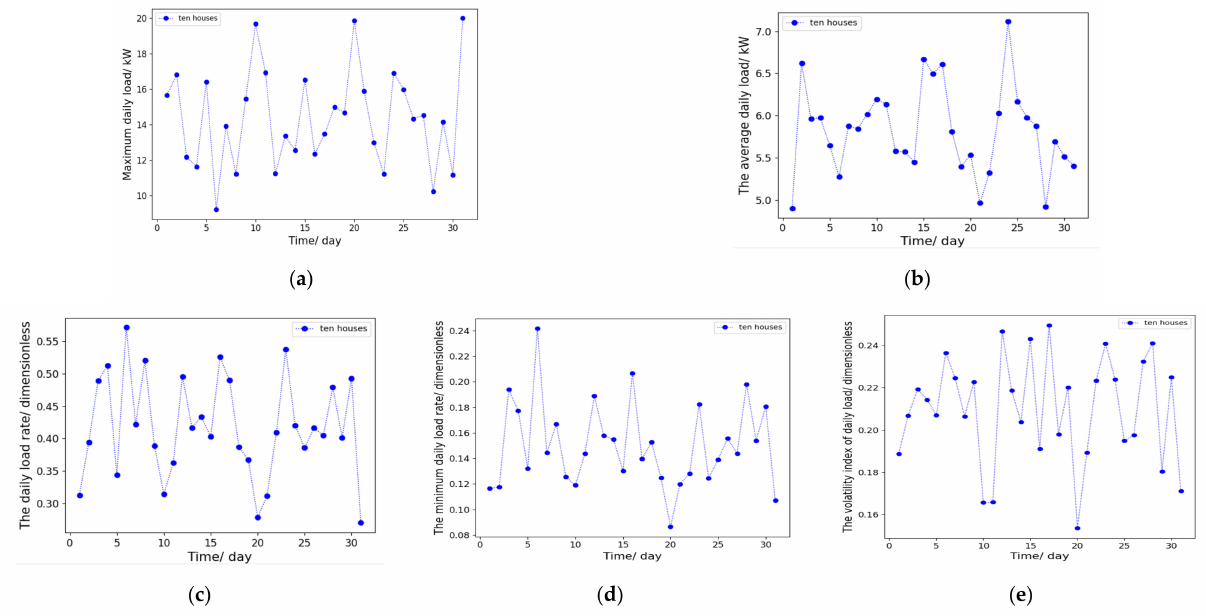
Figure 4. The quantitative indexes of total electric loads of the ten selected residents: ( a ) maximum daily load; ( b ) mean daily load; ( c ) daily load rate; ( d ) minimum daily load rate; ( e ) volatility